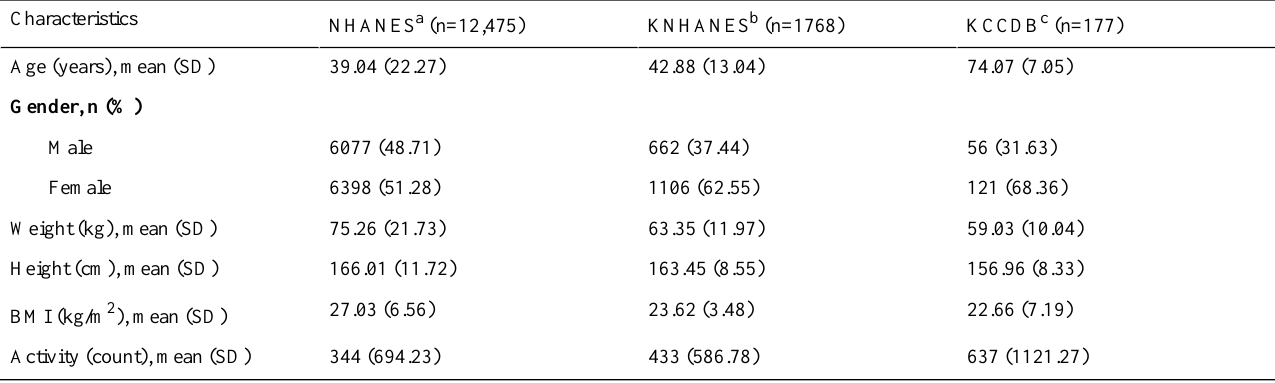
a NHANES: National Health and Nutrition Examination Survey data set (device: ActiGraph AM-7164; type: uniaxial; sample rate: 0.016 Hz). b KNHANES: Korea National Health and Nutrition Examination Survey data set (device: ActiGraph GTX3+; type: triaxial; sample rate: 0.016 Hz). c KCCDB: Korean Chronic Cerebrovascular Disease Oriented Biobank data set (device: Fitmeter; type: triaxial; sample rate: 0.01